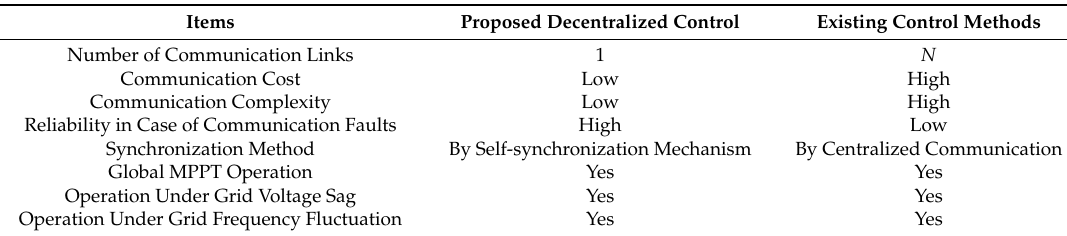
Table 2. Comparison with Existing Control